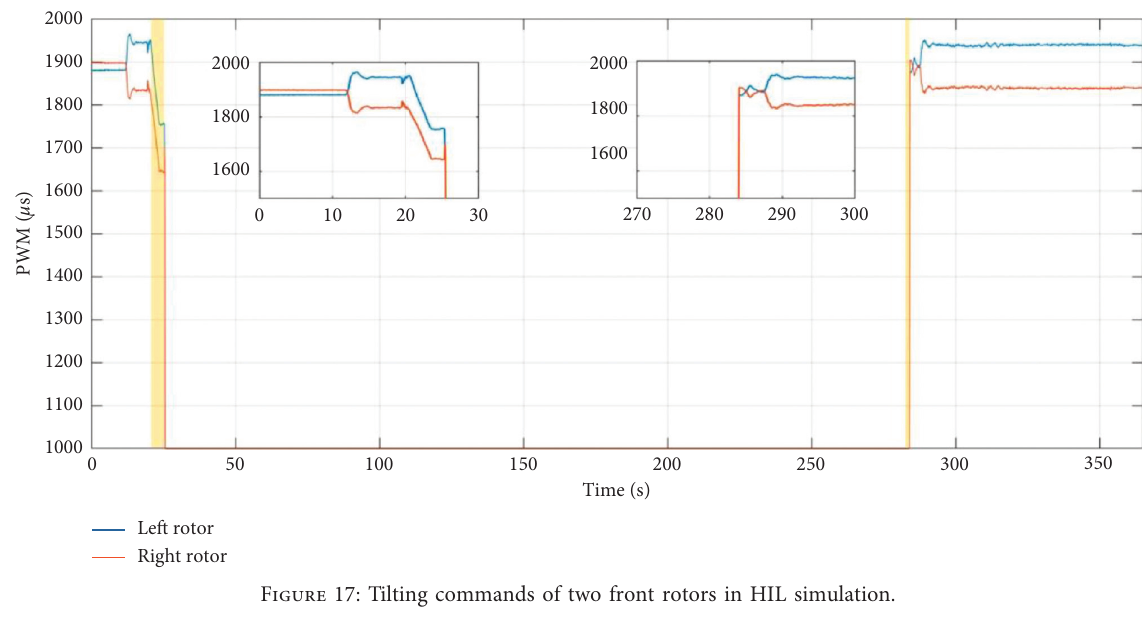
Figure 17: Tilting commands of two front rotors in HIL simulation.